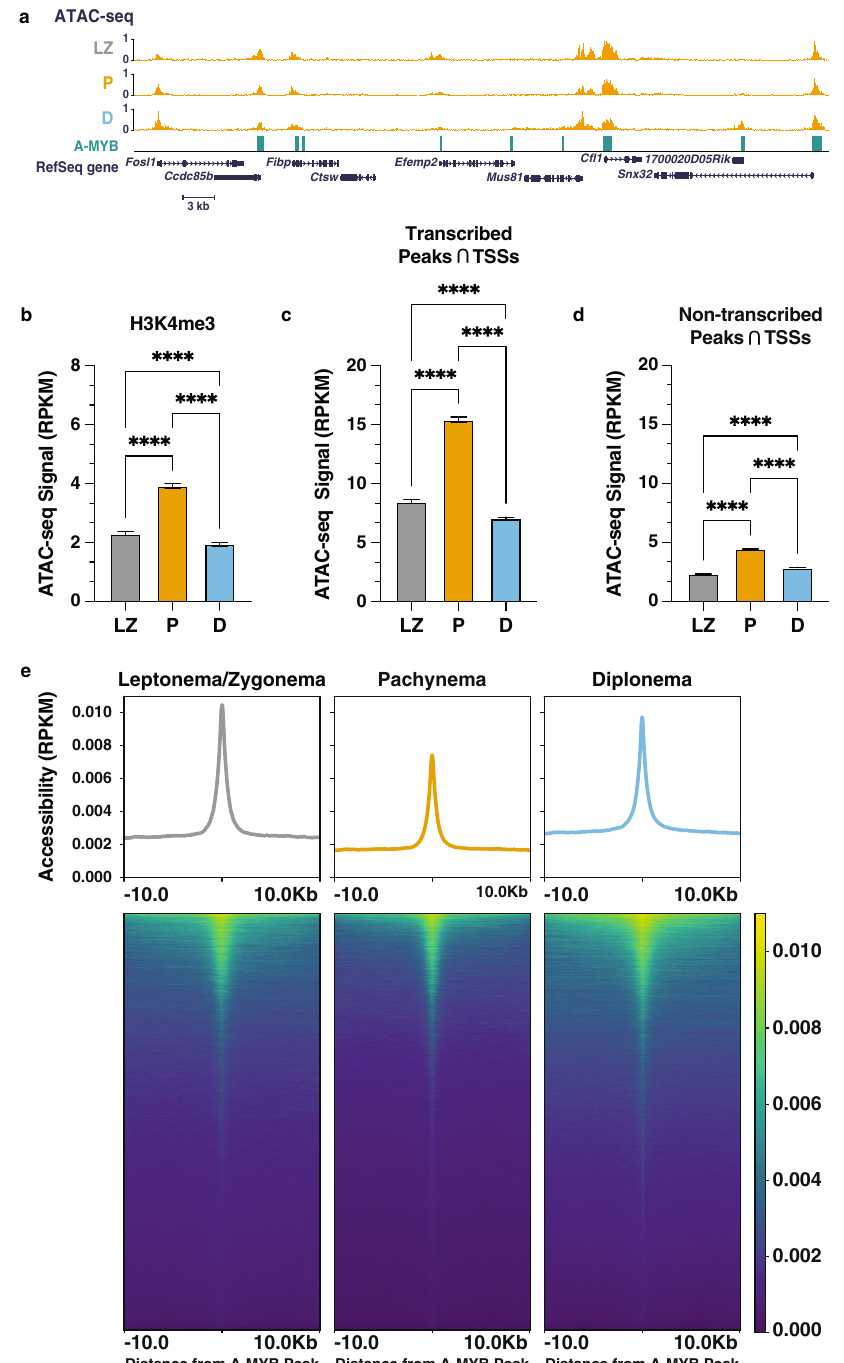
Fig. 6 | Reprogramming of meiotic chromatin architecture is facilitated by A-MYBbinding. a Reads per kilobase million (RPKM)-normalized ATAC-seqsignal at the Mus81 locus for leptonema/zygonema (top), pachynema (center), and diplonema (bottom).A-MYBChIP-seq peaksare shown. b – d Stage-resolved RPKM- normalizedATAC-seqsignalatH3K4me3ChIP-seqpeaks( b );transcribedATAC-seq peaks that overlap with annotated transcription start sites (TSSs) ( c ); non- transcribed ATAC-seq peaks that overlap with TSSs ( d ). Mean±95% con fi dence